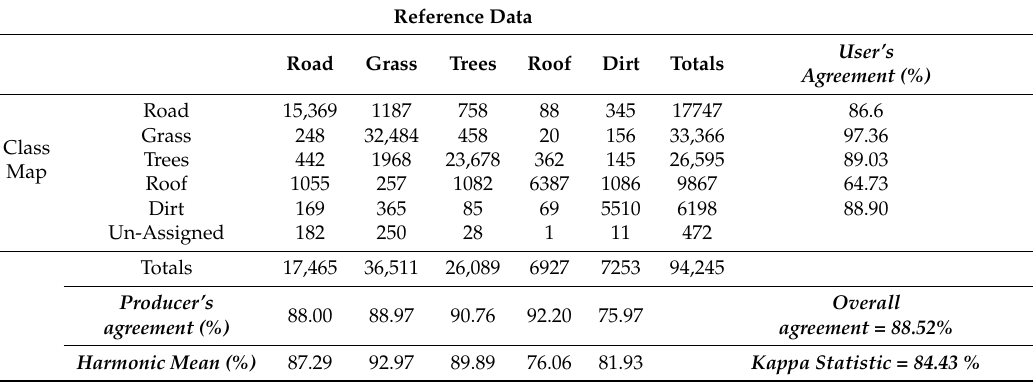
Table 2. Agreement matrix between reference and filtered classification maps for Urban.